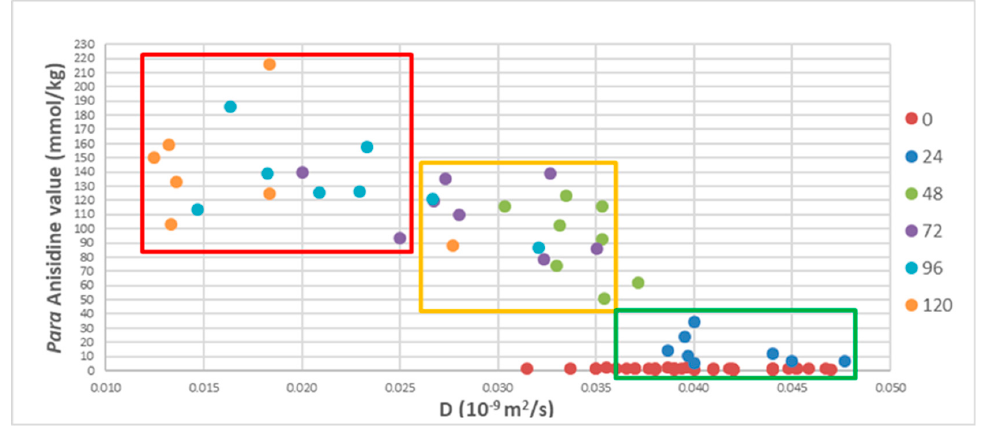
Figure 3. Relationship between para -anisidine values (PAV) and diffusion coefficient (D) of linseed oil during thermal oxidation at 80 ˚ C. Averages of 38 analyses for each point taken from the database (S1) were used.